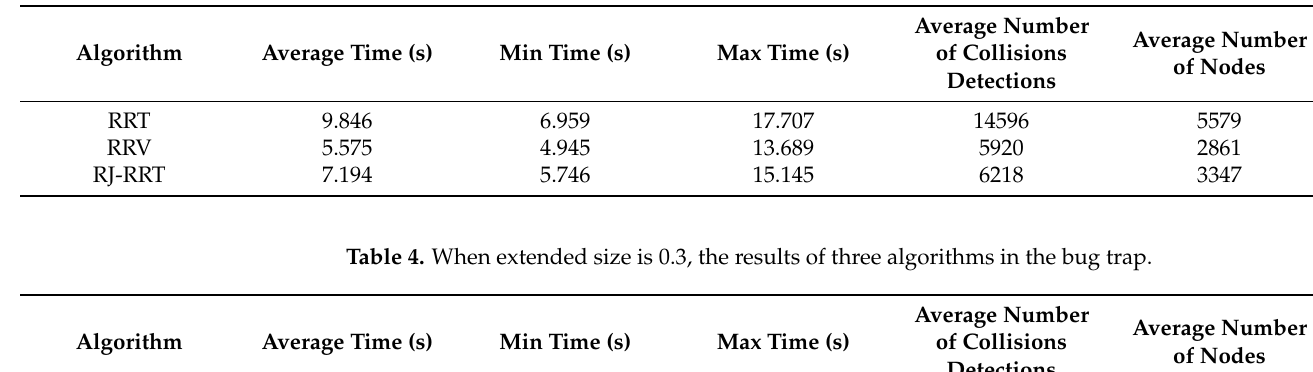
Figure 10. The performance of the three algorithms in bug trap. ( a ) RRT; ( b ) RRV; ( c ) RJ-RRT. Table 3. When extended size is 0.1 , the results of three algorithms in the bug trap.